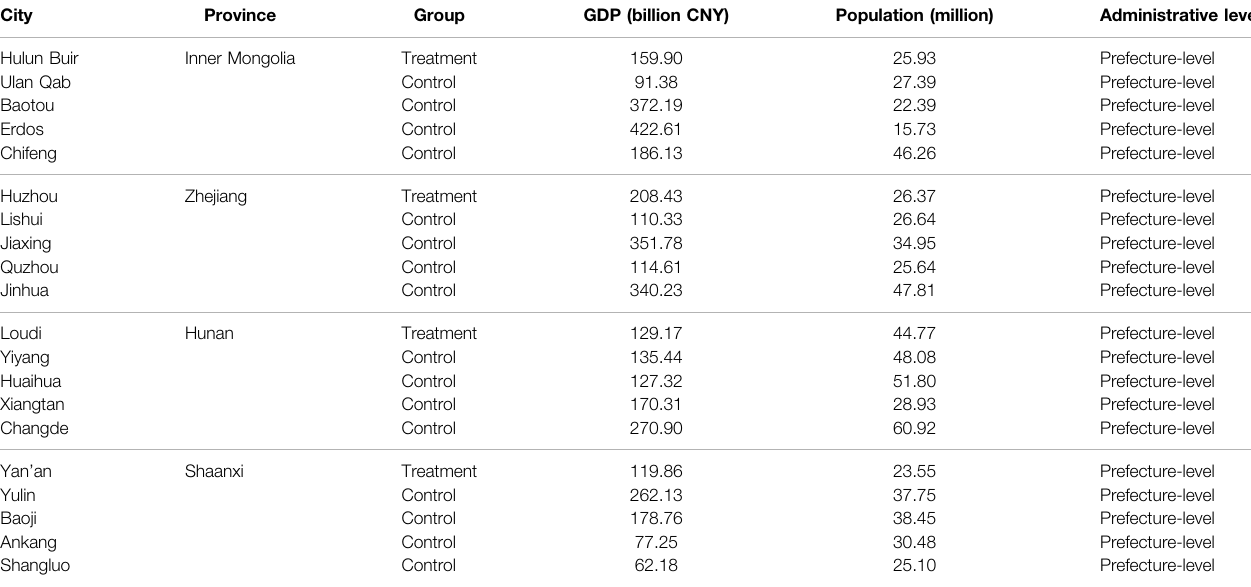
TABLE 1 | A comparison between the treatment and the control